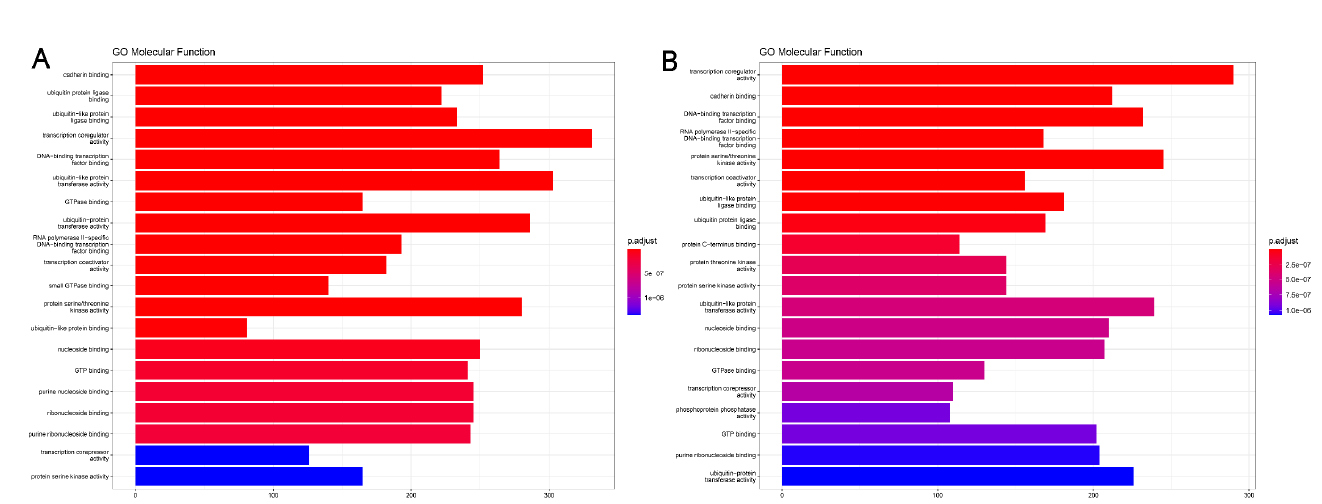
Figure 1. (A) Top 20 GO:MF terms enriched by our top 10 upregulated miRNAs; (B) Top 20 GO:MF terms enriched by our top 10 downregulated miRNAs. Figure 1. ( A ) Top 20 GO:MF terms enriched by our top 10 upregulated miRNAs; ( B ) Top 20 GO:MF terms enriched by our top 10 downregulated